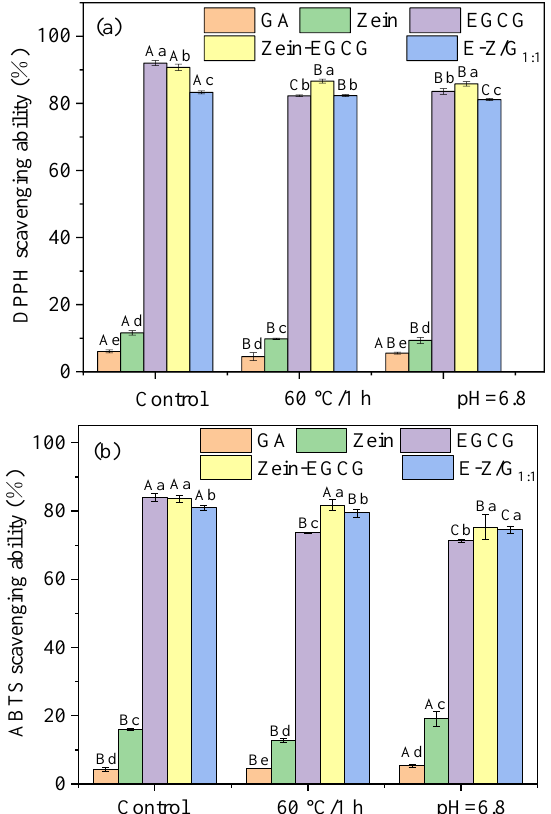
Figure 7. DPPH ( a ) and ABTS ( b ) radical scavenging capacity of different samples. The concentration of Zein, GA, and Zein-GA was 0.2% and the content of EGCG was 100 mg/L. Different lowercase letters represents the significant difference within groups and different uppercase letters represent a significant difference across groups.